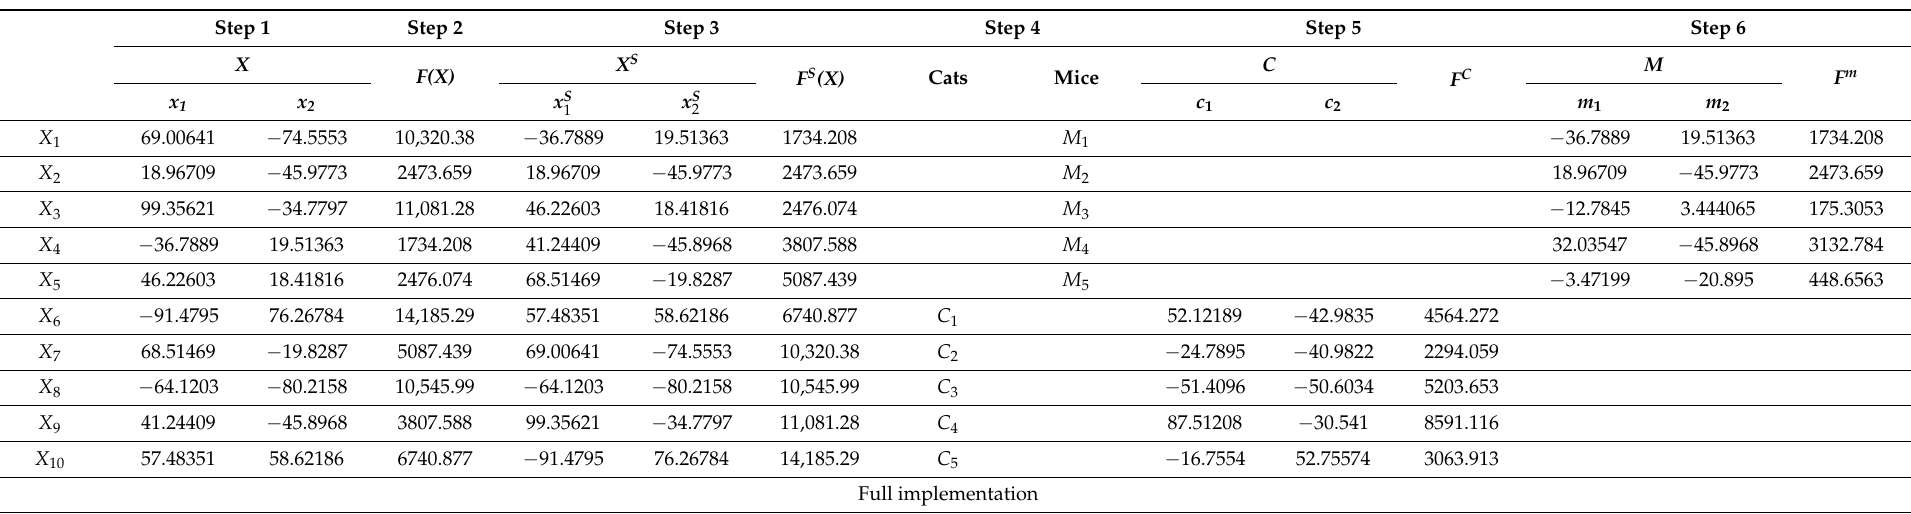
Table 2. The various steps of the proposed CMBO for the first iteration in sphere function